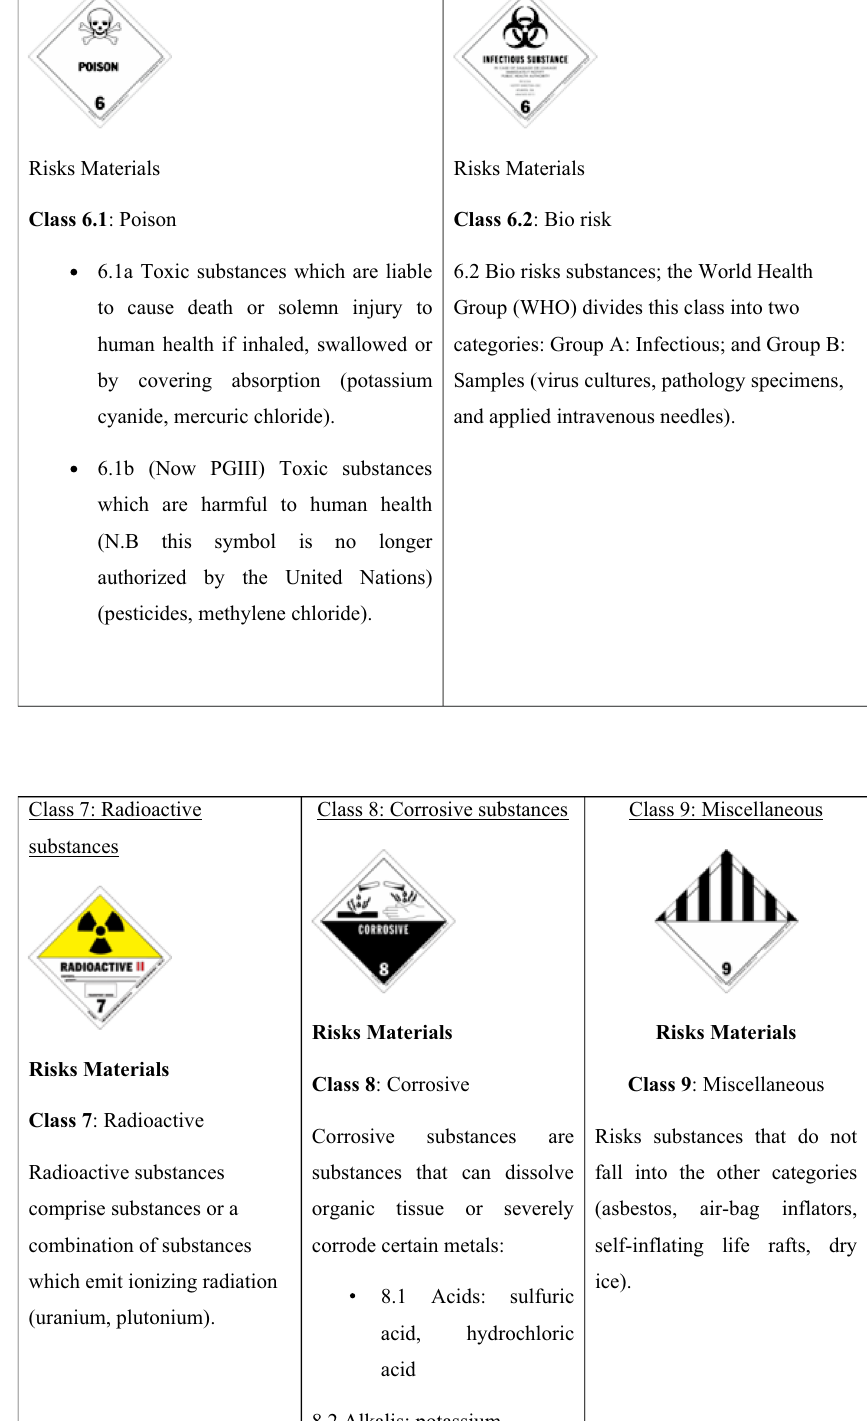
Fig. 6 Class 6, Toxic and infec-